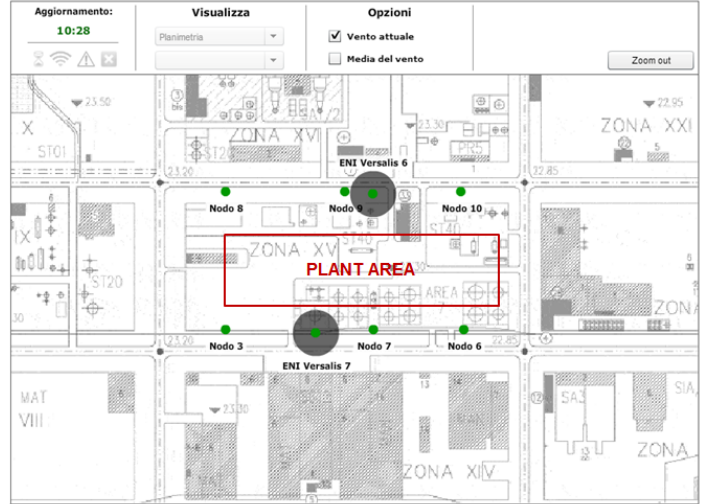
Figure 10. Layout of the six VOC detectors located around a chemical plant in Mantova.